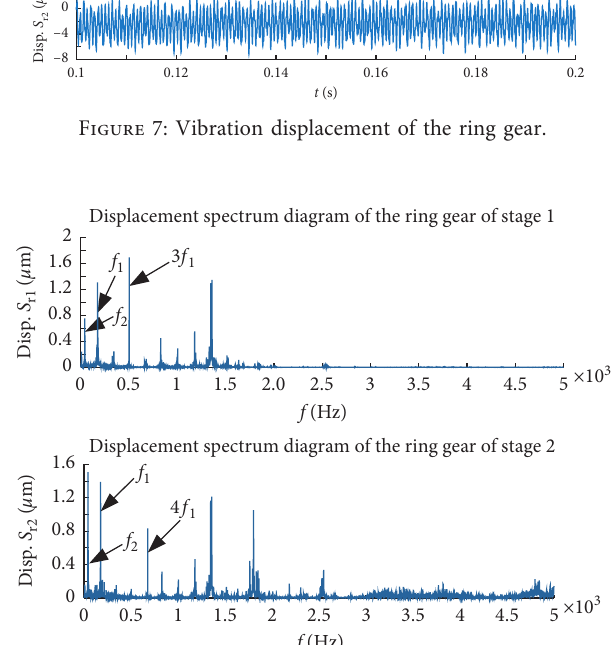
Figure 8: Vibration displacement-frequency spectrum of the ring